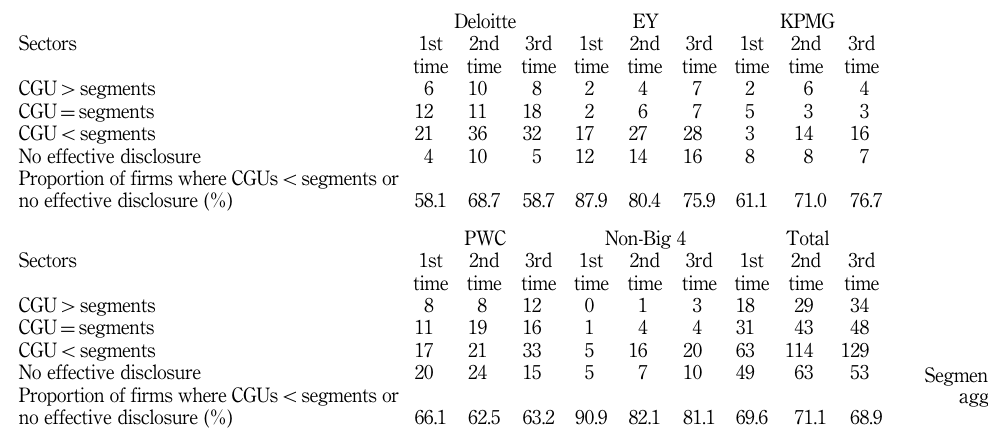
Table IV. Segments and